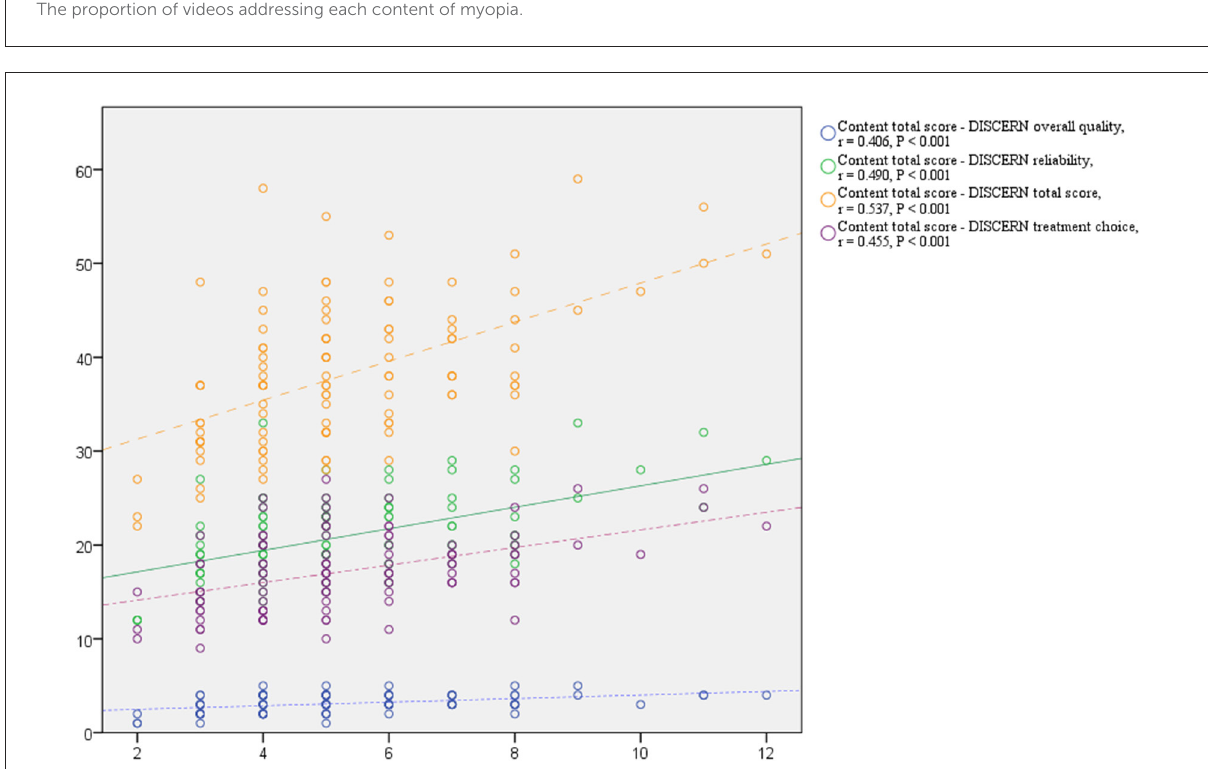
FIGURE4 Scatter plot of DISCERN scores and content score. r, coefficient of pearson product-moment